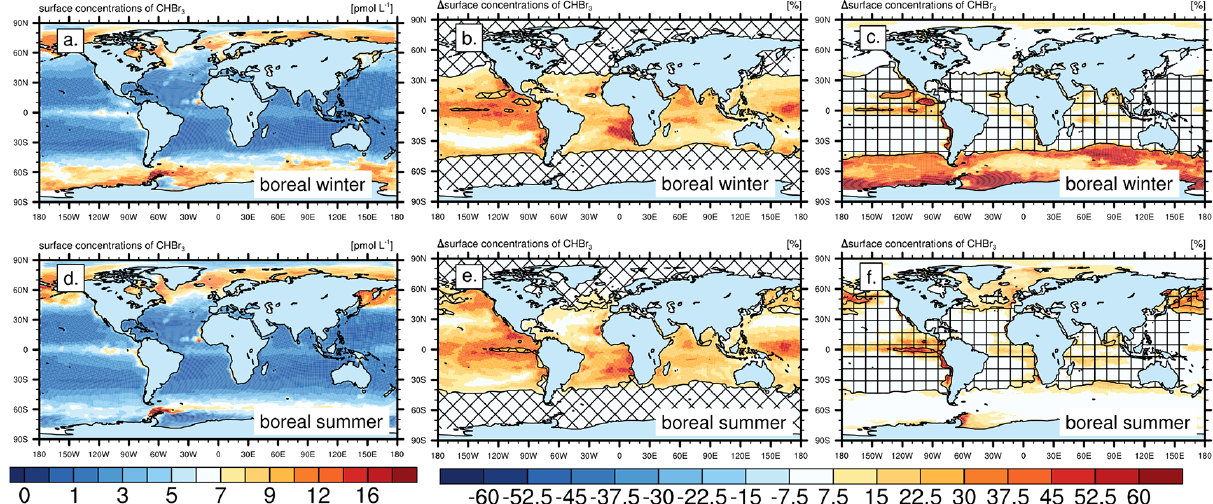
Figure 2. Mean surface bromoform concentrations (pmolL − 1 ) in experiment Half in boreal winter (a) and boreal summer (d) and the percentage difference (e.g. 100 · Dia − Half ) of Dia (b, e) and NDia (c, f) in the same season. Mesh patterns show regions where the fraction Half of diatoms (b, e) or non-diatoms (c, f) in bulk phytoplankton dominates (i.e. fraction > 0 . 5) (inclined mesh for diatoms, straight mesh for